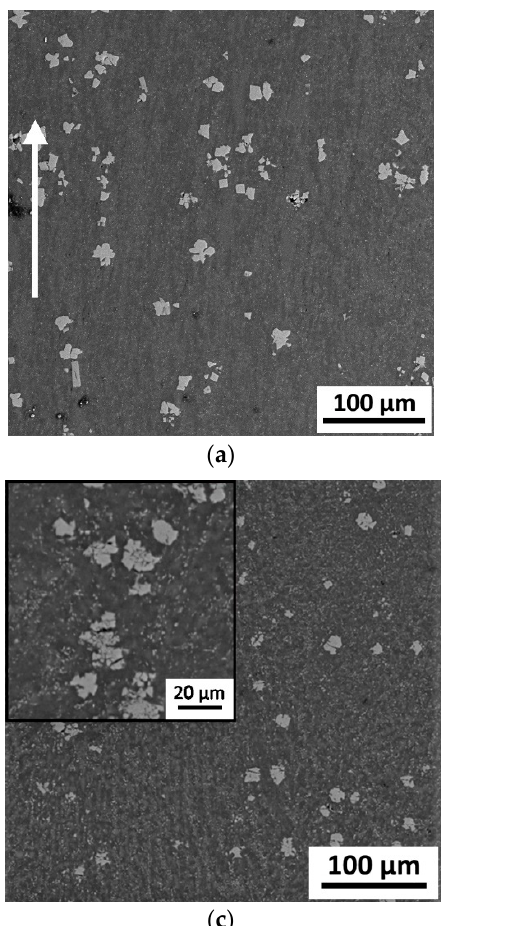
Figure 8. Hot-rolled sheets: ( a ) Al-6Ca-3Mn; ( b ) Al-8Ca-2Mn; ( c ) Al-8Ca-2Mn-1Ni; ( d ) FM180.